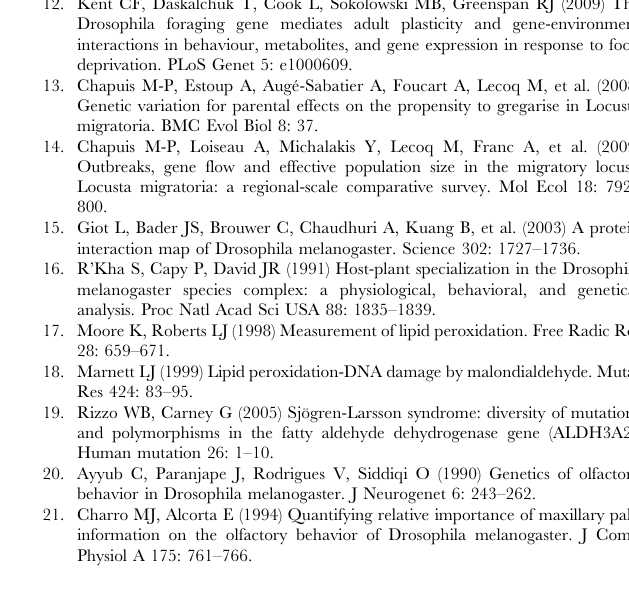
Figure S5 Model for Aldh-III activation. This scheme summarizes the proposed molecular interactions of CG11699 (15 kDa protein with two trans-membrane domains and a short cytosolic sequence bearing putative phosphorylation sites for PKG, PKA and casein kinase) with Aldh-III and for proteins. The expression of Aldh-III is inducible in mammals through xeno- sensors (transcription factors directly activated by xenobiotics). The phosphorylation of CG11699 might regulate the activity of Aldh-III referred by authors as a membrane-cleaning enzyme.